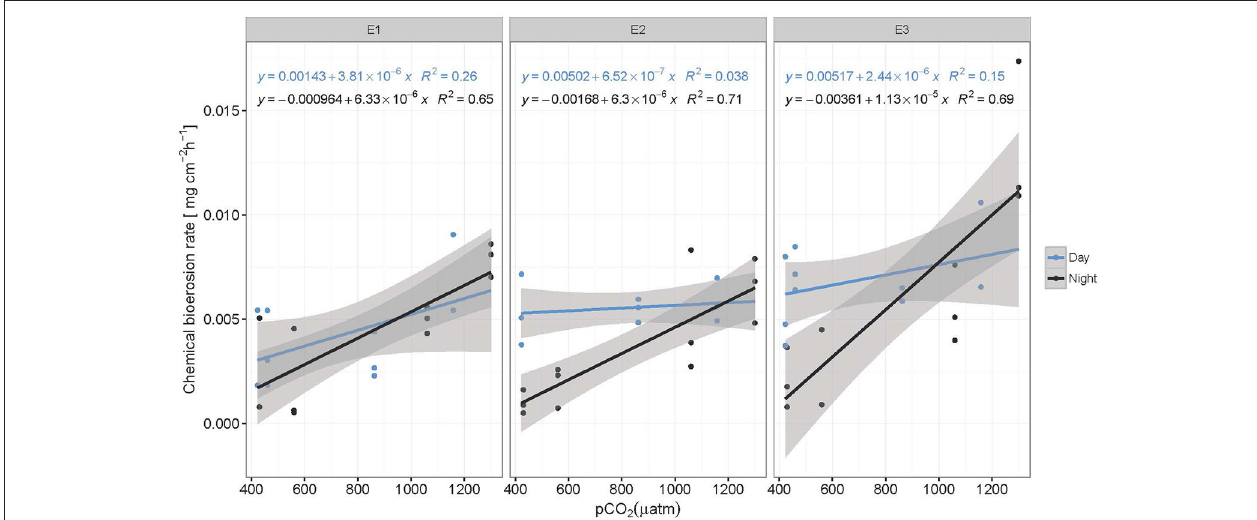
FIGURE 3 | Chemical bioerosion rates in mg cm − 2 h − 1 as a function of p CO 2 for day and night and each eutrophication treatment. Linear regressions illustrate positive correlation between p CO2 and dissolution rates. Slopes are significantly different between day (blue) and night (black) but not between eutrophication scenarios (E1–E3). Alkalinity titrations for incubations in Present scenario (PD) and E2 treatment during the day were of questionable quality due to equipment failure and therefore not represented here ( N =